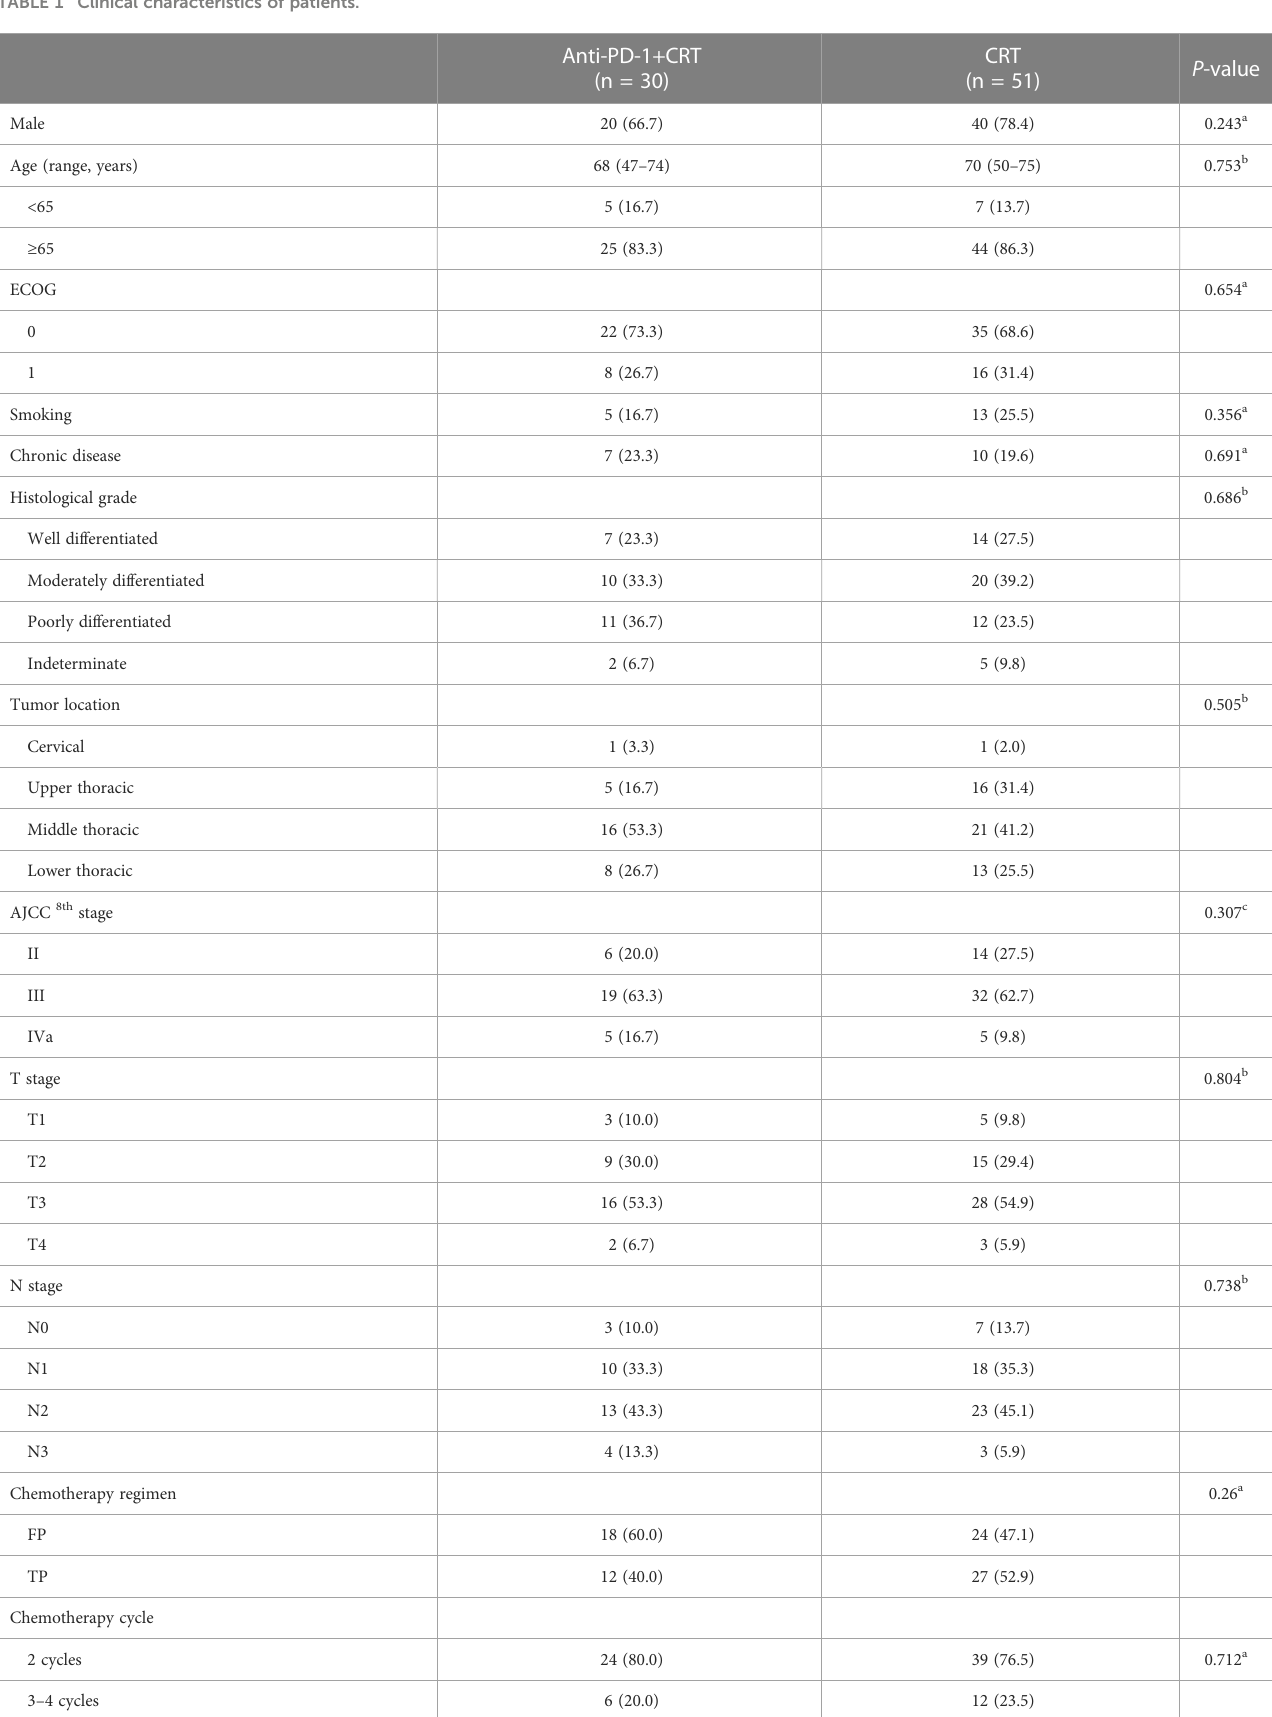
TABLE 1 Clinical characteristics of